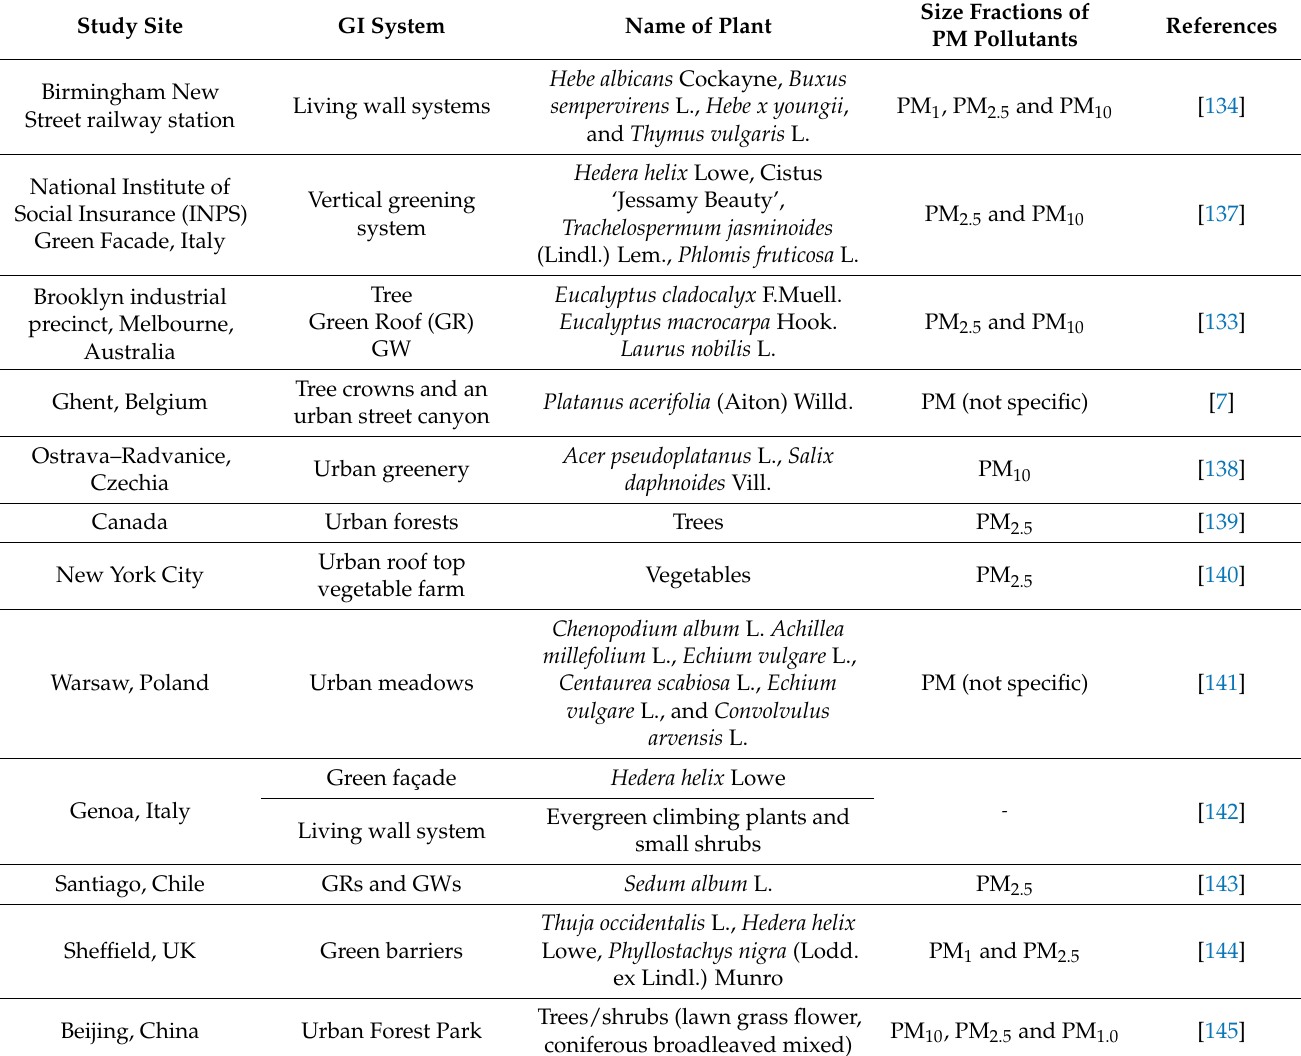
Table 1. Different types of